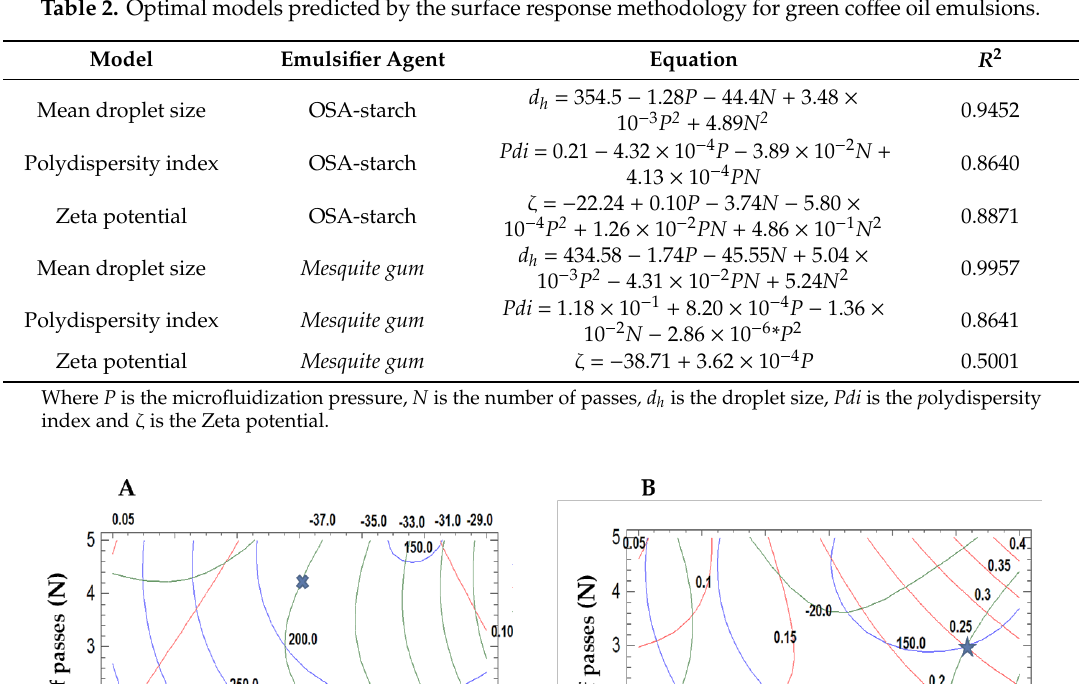
Table 2. Optimal models predicted by the surface response methodology for green co ff ee oil emulsions.